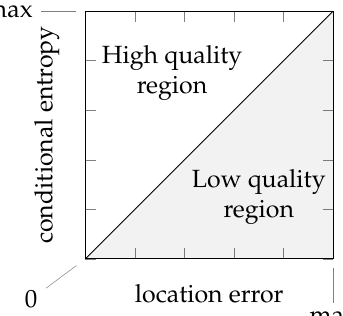
Figure 6. An estimate of a perfect linear relationship between the location error and conditional entropy divides the space of the two metrics into halves: we say that the upper triangle is the region where samples of high quality sensor models can be found and the lower triangle is the region where samples of low quality sensor models can be found. This allows us to calculate a quality measure, although it is only indicative. We are especially interested in the border cases, with very small conditional entropy and very large location